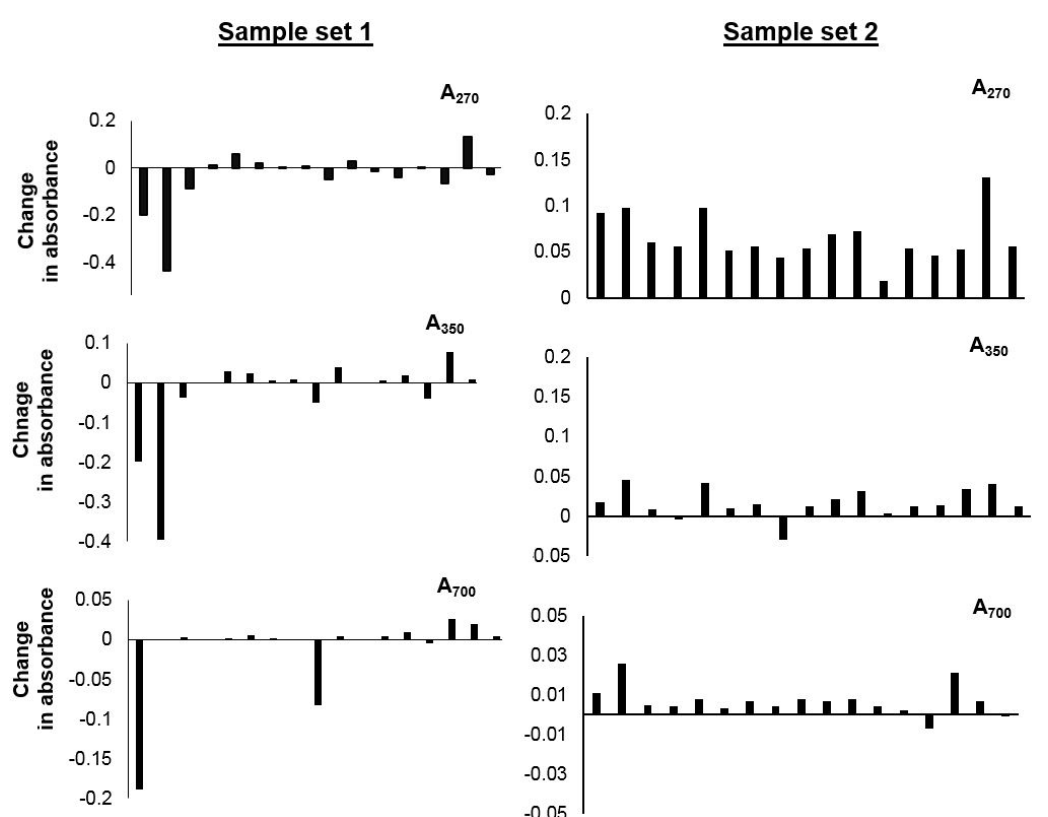
Figure 3. Experiment 2: changes in absorbance at 270 nm ( A 270 ), 350 nm ( A 350 ) and 700 nm ( A 700 ) of samples during approximately 12 weeks of cold storage (4 °C) Positive values are increases. There are two sets of 17 samples. Set 1 was collected on 03 August 2015, and set 2 on 05 October 2015.